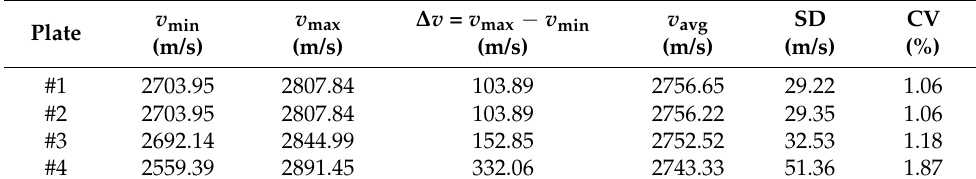
Table 2. Wave propagation velocities in steel plates for data from numerical tests.